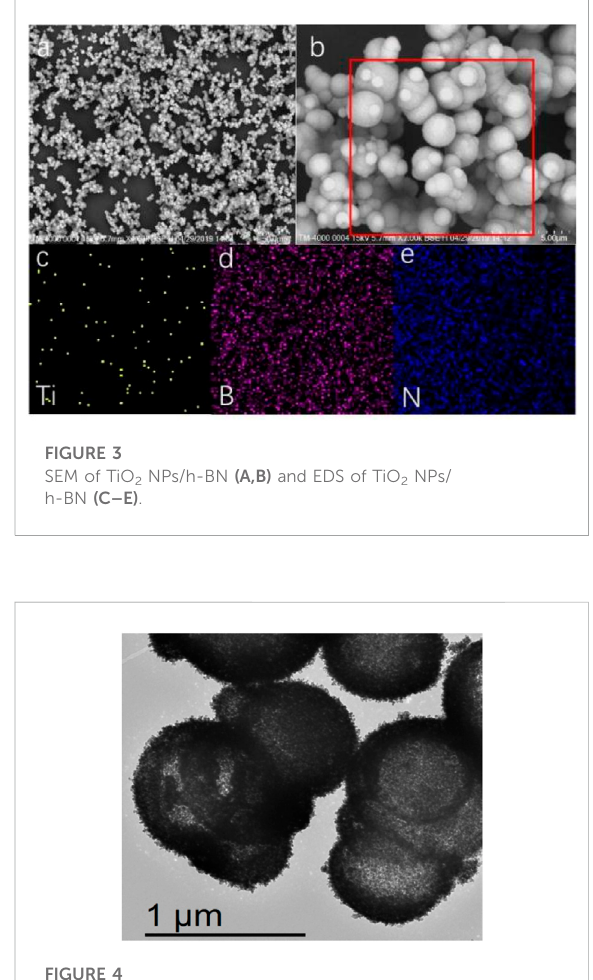
FIGURE 4 TEM of TiO 2 NPs/h-BN